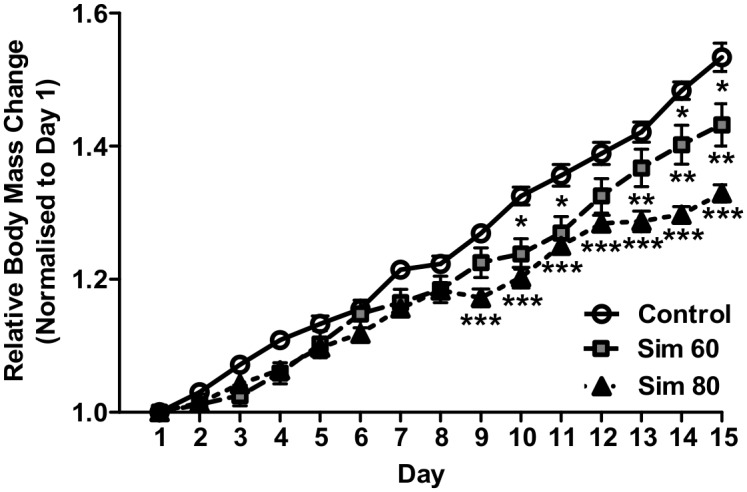
The effect of simvastatin treatment on body mass.Rats were treated with vehicle (Control) or simvastatin at 60 (Sim 60) and 80 mg.kg-1.day-1 (Sim 80) for 14 days. Body mass was normalized to each rat’s initial starting mass (day 0). *—Sim 60 significantly different from Control. **—Sim 80 significantly different from Sim 60. ***—Sim 80 significantly different from Control. Mean ± SEM. n = 8/group. Two way ANOVA with repeated measures and Bonferonni’s post-hoc test. P < 0.05.